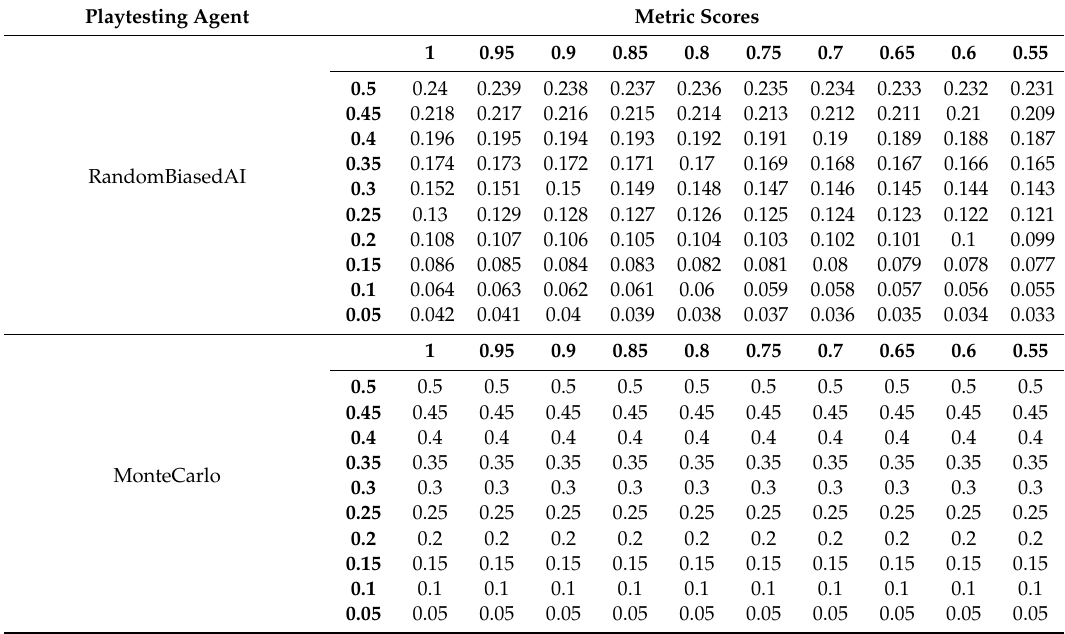
Table A1. Metric scores with variable weights for all the playtesting